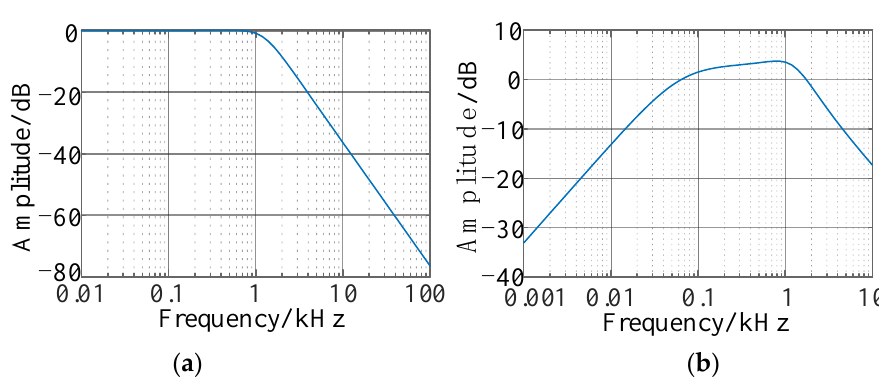
Figure 10. The bode plots without resonance controller. ( a ) G i_cl ( s ) ; ( b ) G u_i ( s ).